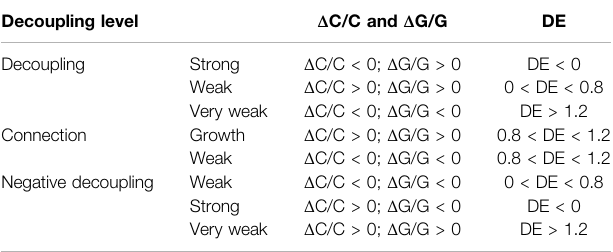
TABLE 1 | Decoupling